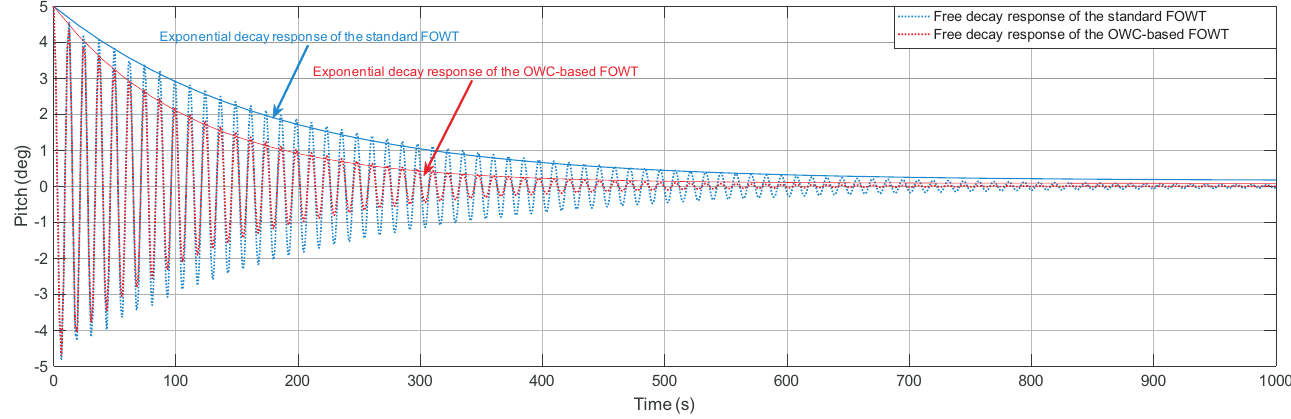
Figure 4. Free decay response for the platform pitch in the standard FOWT and OWC-based FOWT. In Figure 5, the top tower fore-aft displacement is illustrated for both structures and the same can be deduced; the oscillations of the fore-aft displacement are reduced in the OWC-based FOWT compared to the standard FOWT.